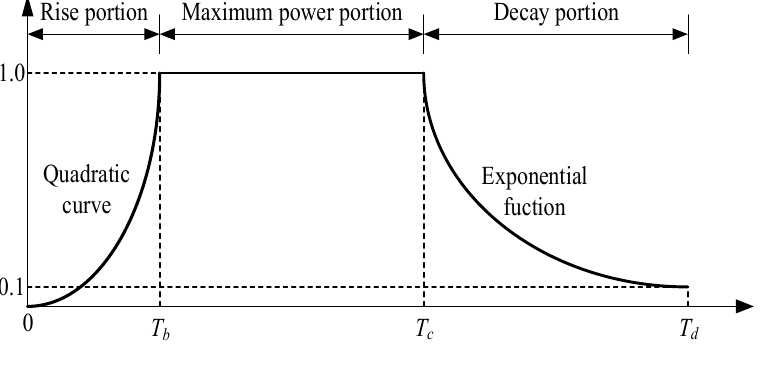
Figure 11. Duration envelope function.